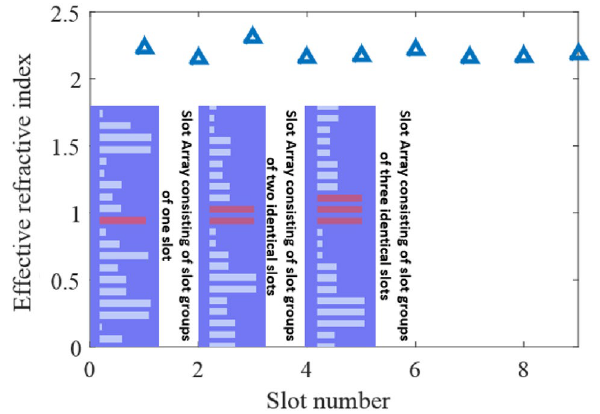
Figure 4. Effective refractive index of a slot group with different number of identical slots. For generating this figure, a slot array with 20 randomly-generated slot lengths is used. The effective refractive index is calculated for slot groups associated with the slot colored in red with the slot length of 1.964